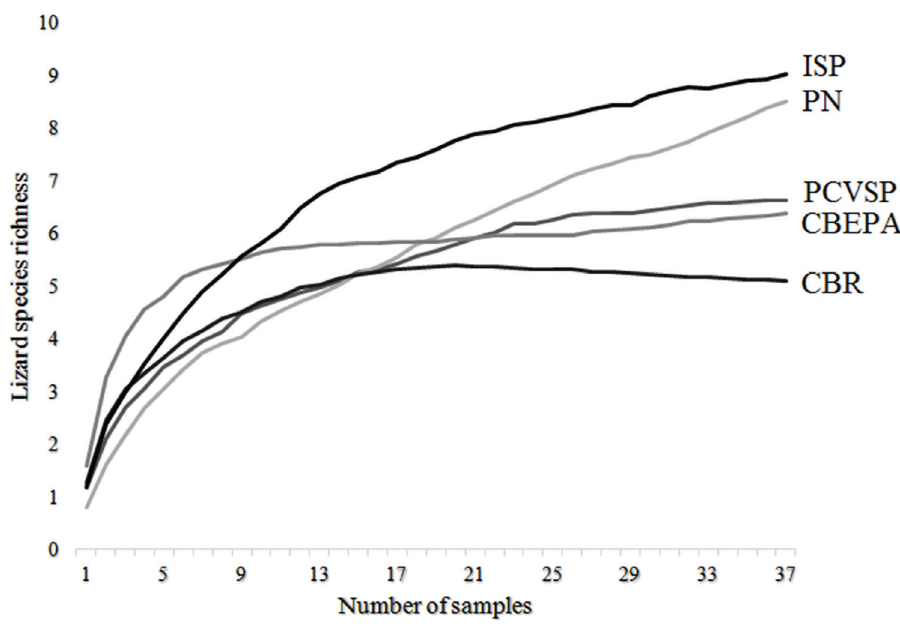
Figure 3 - Species richness curves estimated for lizards for the studied sandy coastal plains in espírito Santo state, Brazil. ISP: Itaúnas State Park; CBEPA: Conceição da Barra Environmental Protection Area; CBR: Comboios Biological Reserve; PCVSP: Paulo Cesar Vinha State Park; PN: Praia das